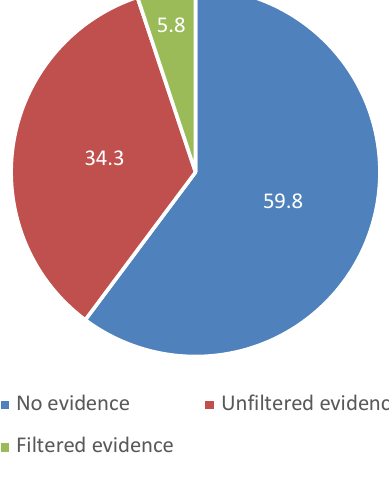
Figure 8: Evidence of Comparison/Control (Average score